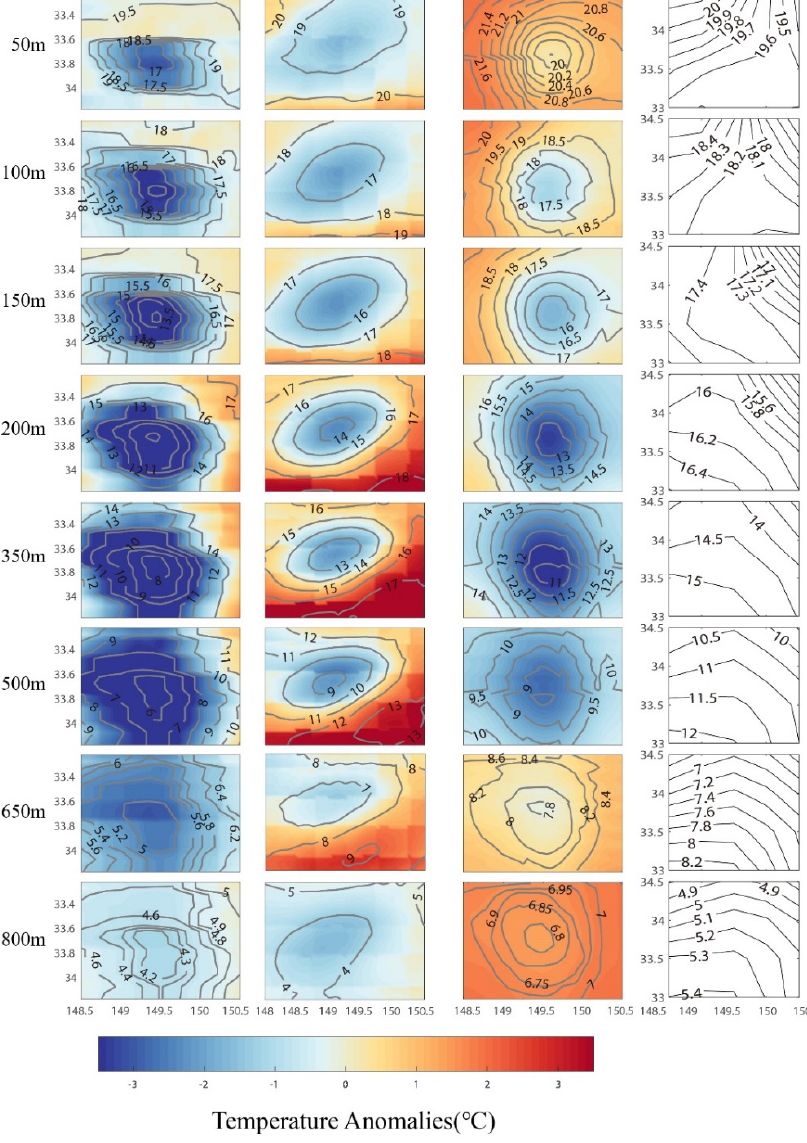
Figure 6. Horizontal distributions of temperature at some specific depth layers. The horizontal axis is longitude and vertical axis is latitude. Same as Figure 5.